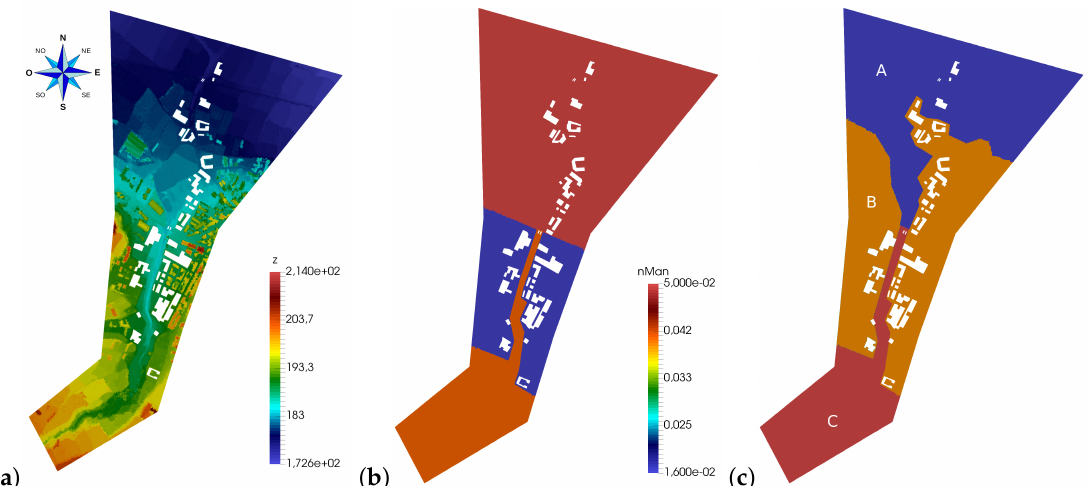
Figure 10. Ginel river at Fuentes de Ebro: Elevation map in m ( a ), Manning roughness coefficients in s m 1/3 ( b ) and infiltration regions ( c